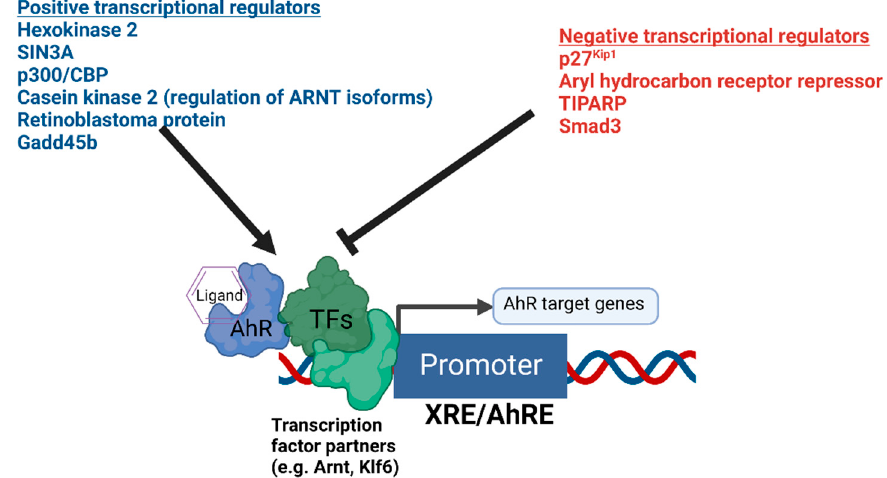
Figure 1. Summary of the positive and negative transcriptional co-regulators of AhR signaling. The diagram depicts AhR bound to DNA in complex with potential heterodimer partner proteins and regulators. Different positive and negative regulators of AhR-mediated transcription are summa- rized above.